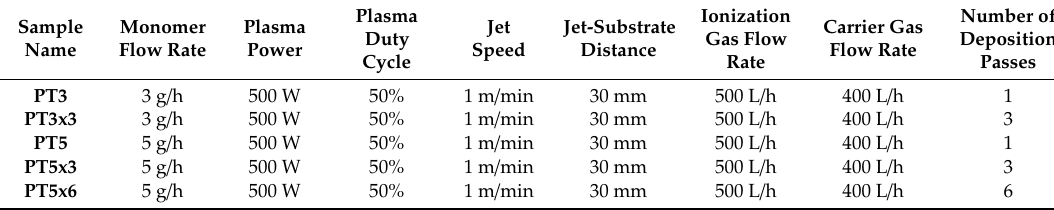
Table 1. Plasma conditions used for preparation of samples.